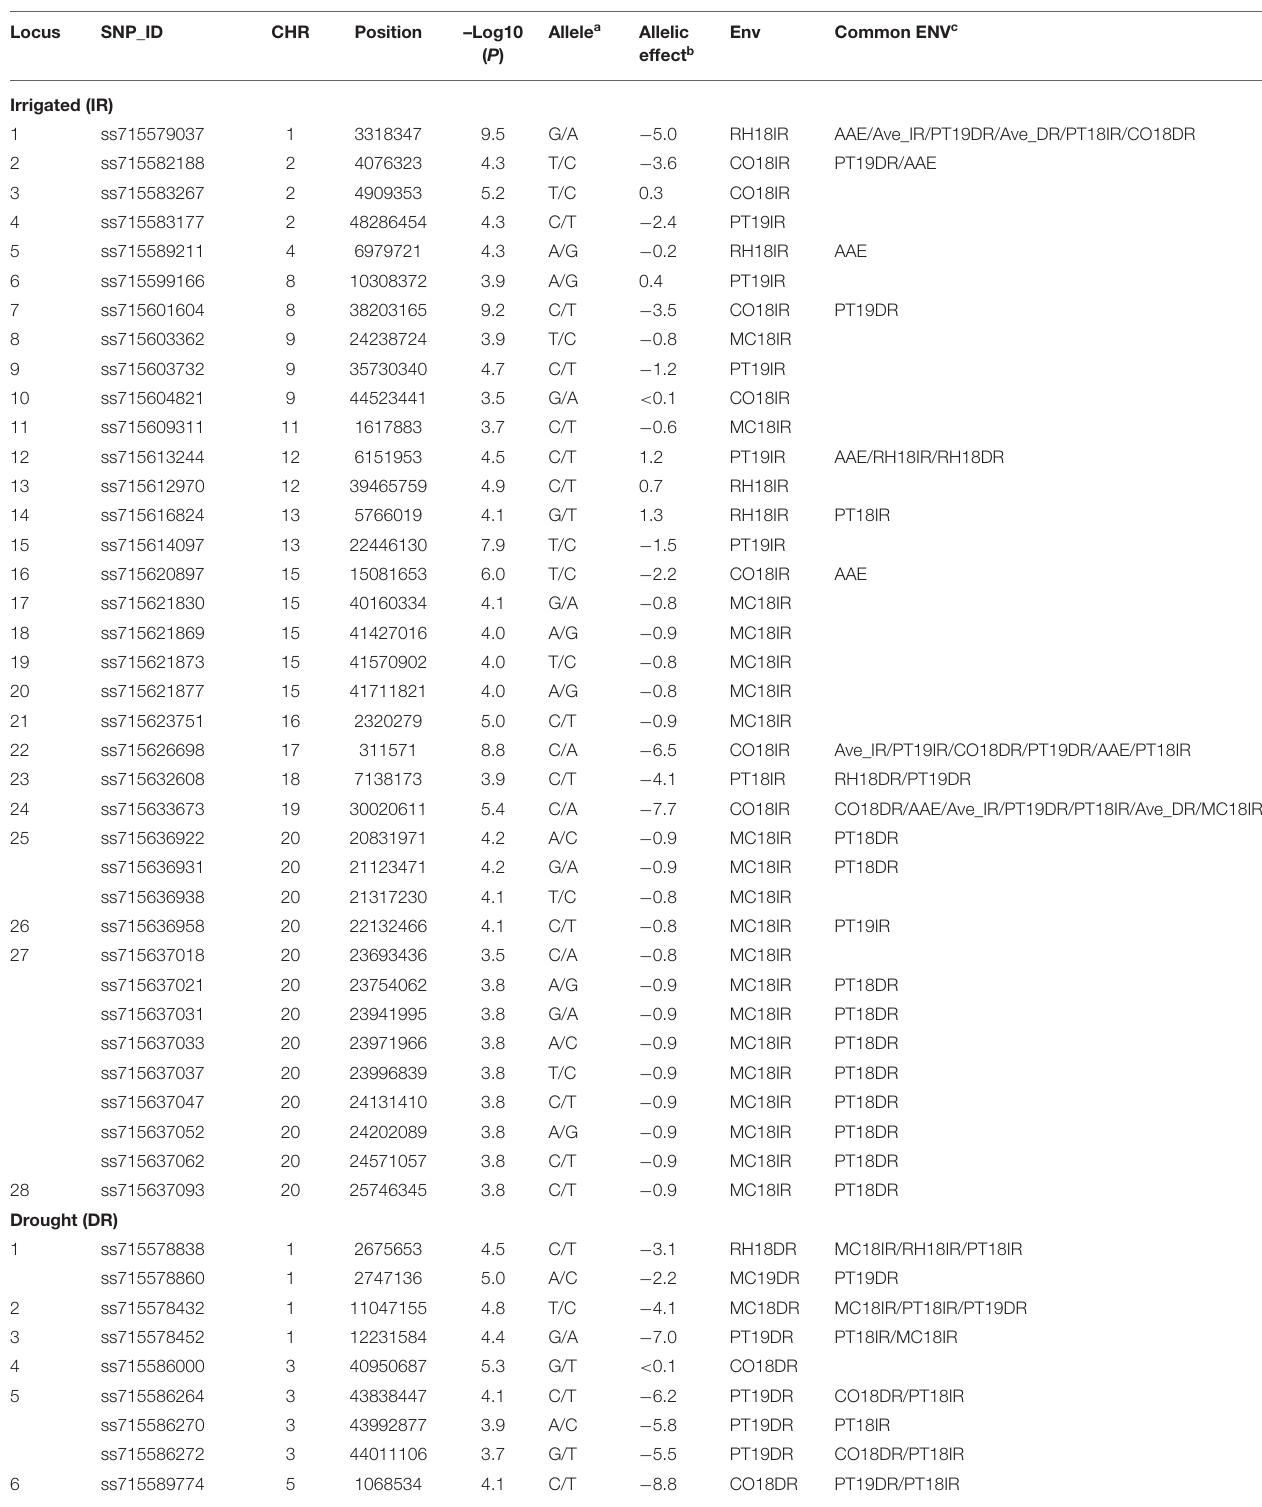
TABLE 4 | Significant novel SNPs identified from this study associated with CW for the 12 environments, Columbia (CO18), Maricopa (MC18 and 19), Pine Tree (PT18 and 19), and Rohwer (RH18) under IR and DR treatments, and for CW scores averaged across site-years for irrigated (Ave_IR) and drought (Ave_DR) treatments, and averaged across all environments (AAE) at the significant threshold P -value [–Log10 ( P ) ≥ 3.5; P ≤ 0.0003]. Locus SNP_ID CHR Position –Log10 Allele a Allelic Env Common ENV ( P ) effect b